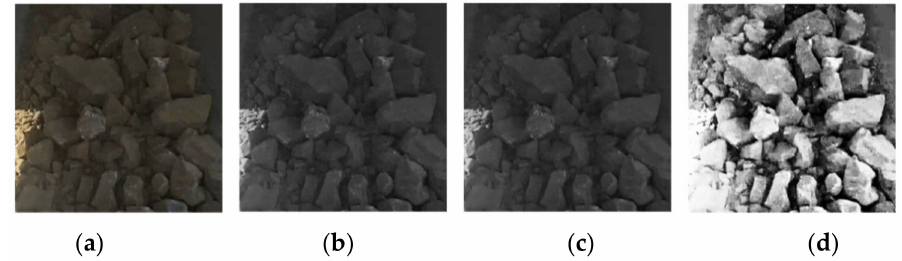
Figure 3. An example of raw image and its preprocessed results: ( a ) the raw image; ( b ) the gray scale image; ( c ) the bilateral filtering result; and ( d ) the contrast-limited adaptive histogram equalization (CLAHE) result.